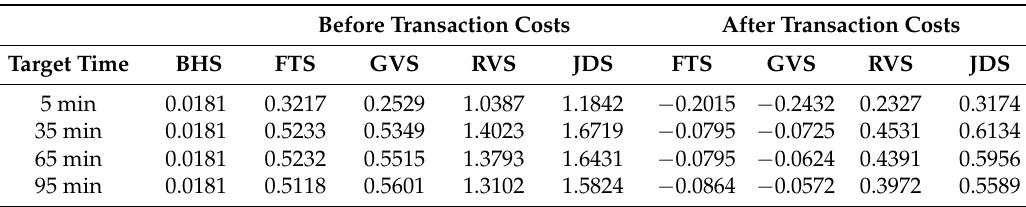
Table 6. Yearly returns for BHS, FTS, GVS, RVS, and JDS for a target time of 5, 35, 65, and 95 min from January 1998–December